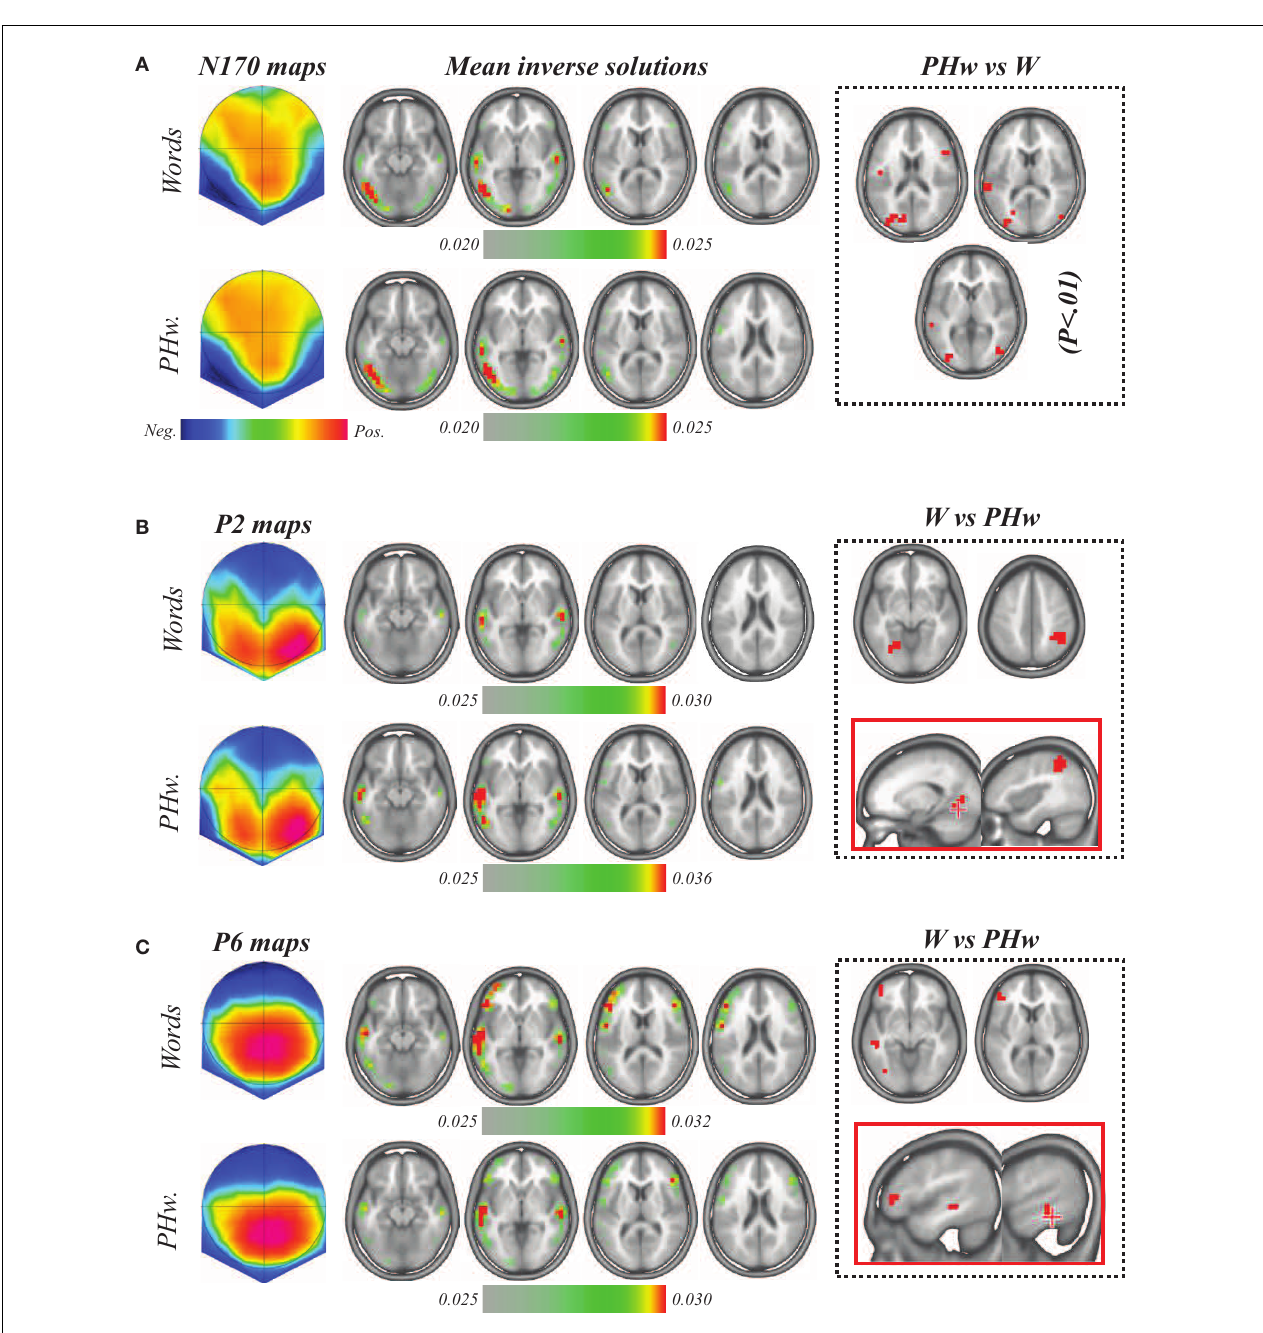
FIGURE 4 | (A) Topographic potential map (left) and average source localization computed during the N170 period from the individual inverse solution in words (upper raw) and PHw (lower raw). In both cases, maximal activity involved left temporo-occipital areas. Paired t -tests comparing inverse solutions to PHw vs. words (significance at p < 0 . 01, right dashed square) showed more activity for PHw in the left posterior areas (see text). (B) Topographic potential map (left) and average source localization computed during the P2 period in words (upper raw) and PHw (lower raw). In both cases, maximal activity was found in bilateral temporal areas. Paired t -tests comparing words vs. PHw showed more activity for words (right dashed